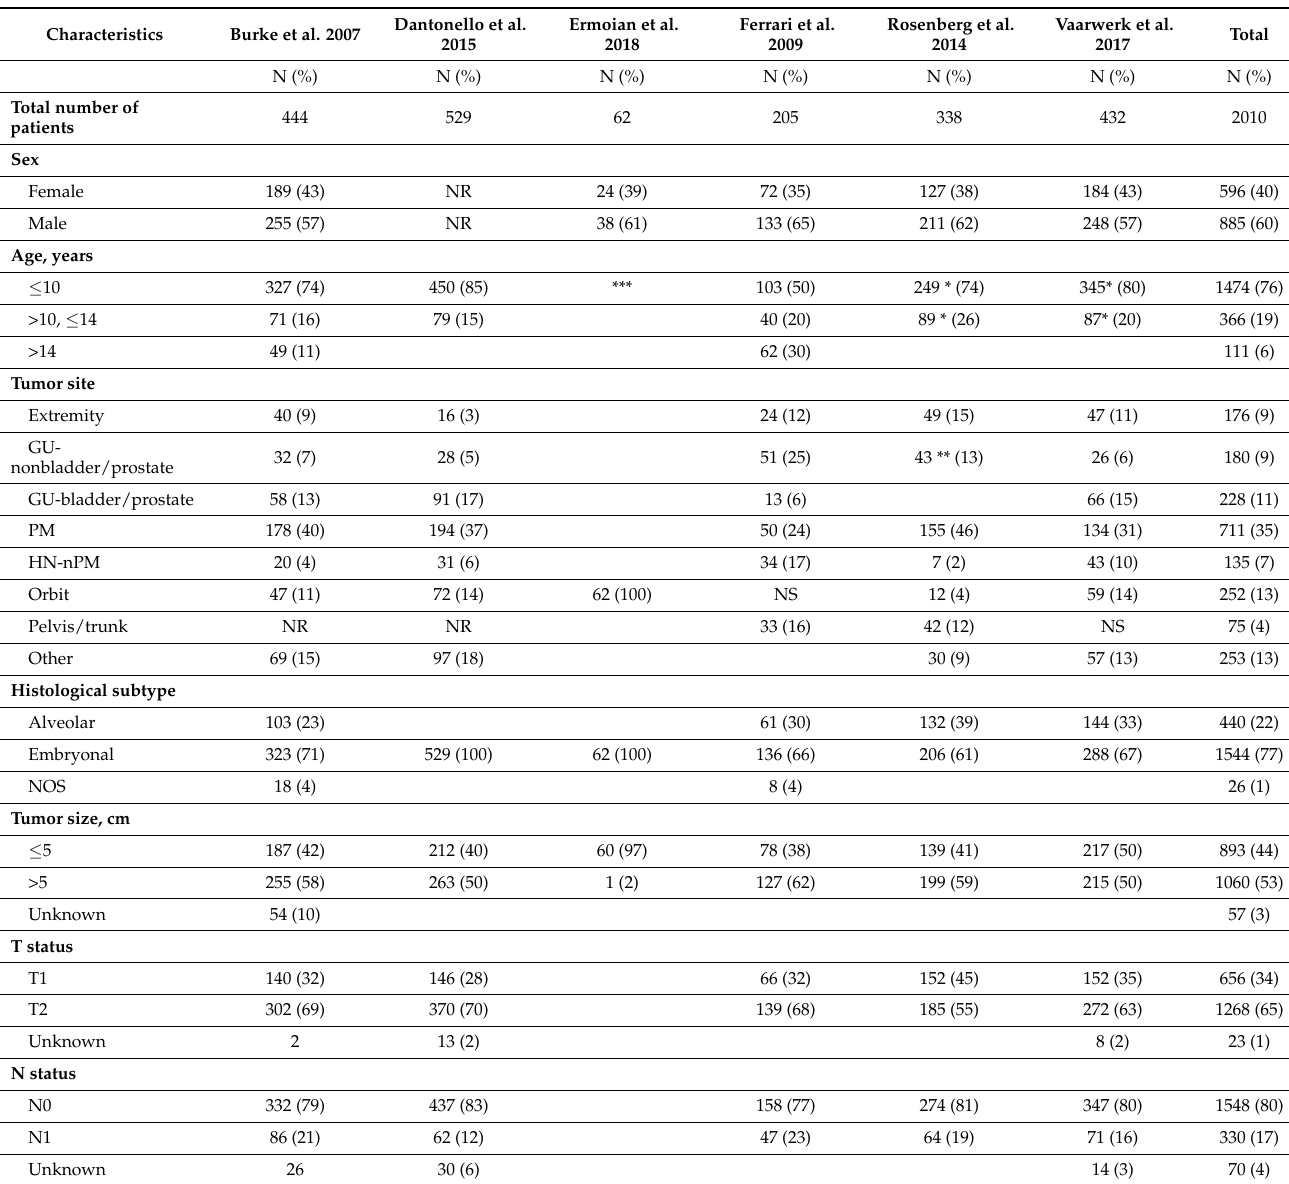
Table 2. Patient characteristics for included